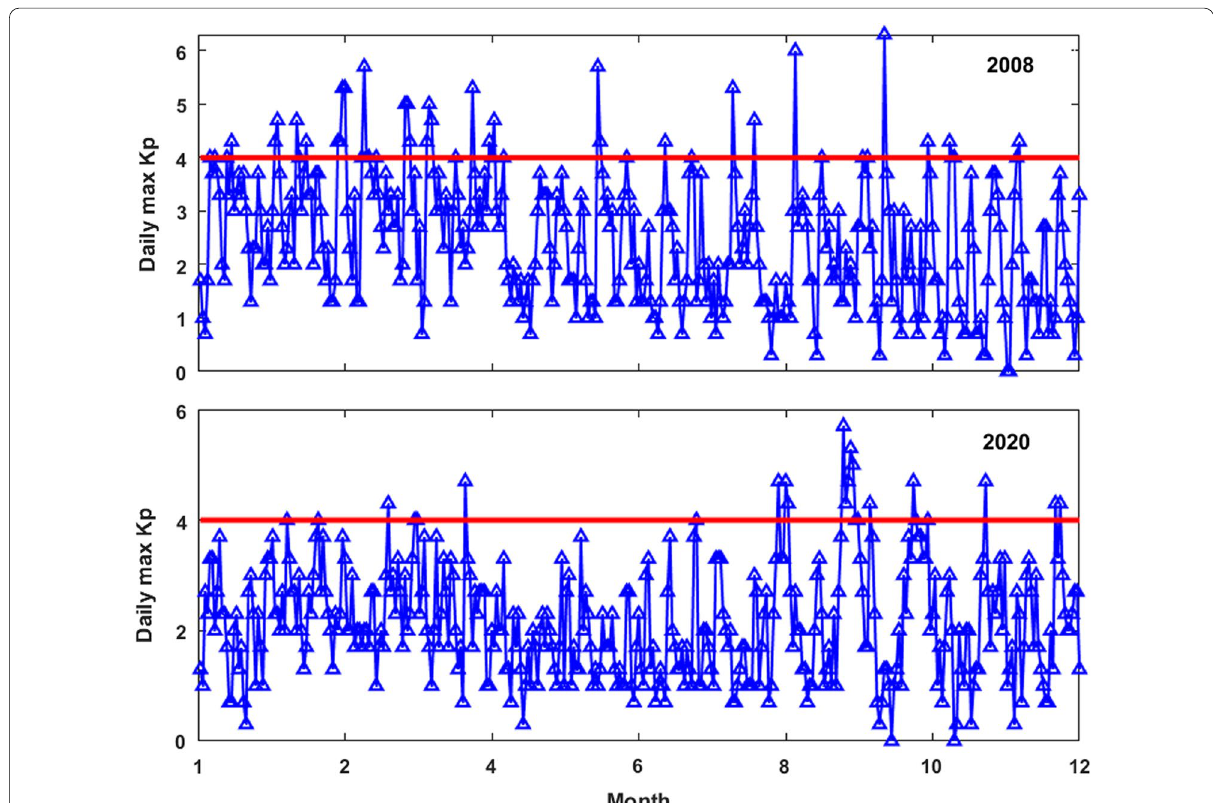
Fig. 6 Daily max Kp indices in 2008 and 2020, red solid line indicates Kp